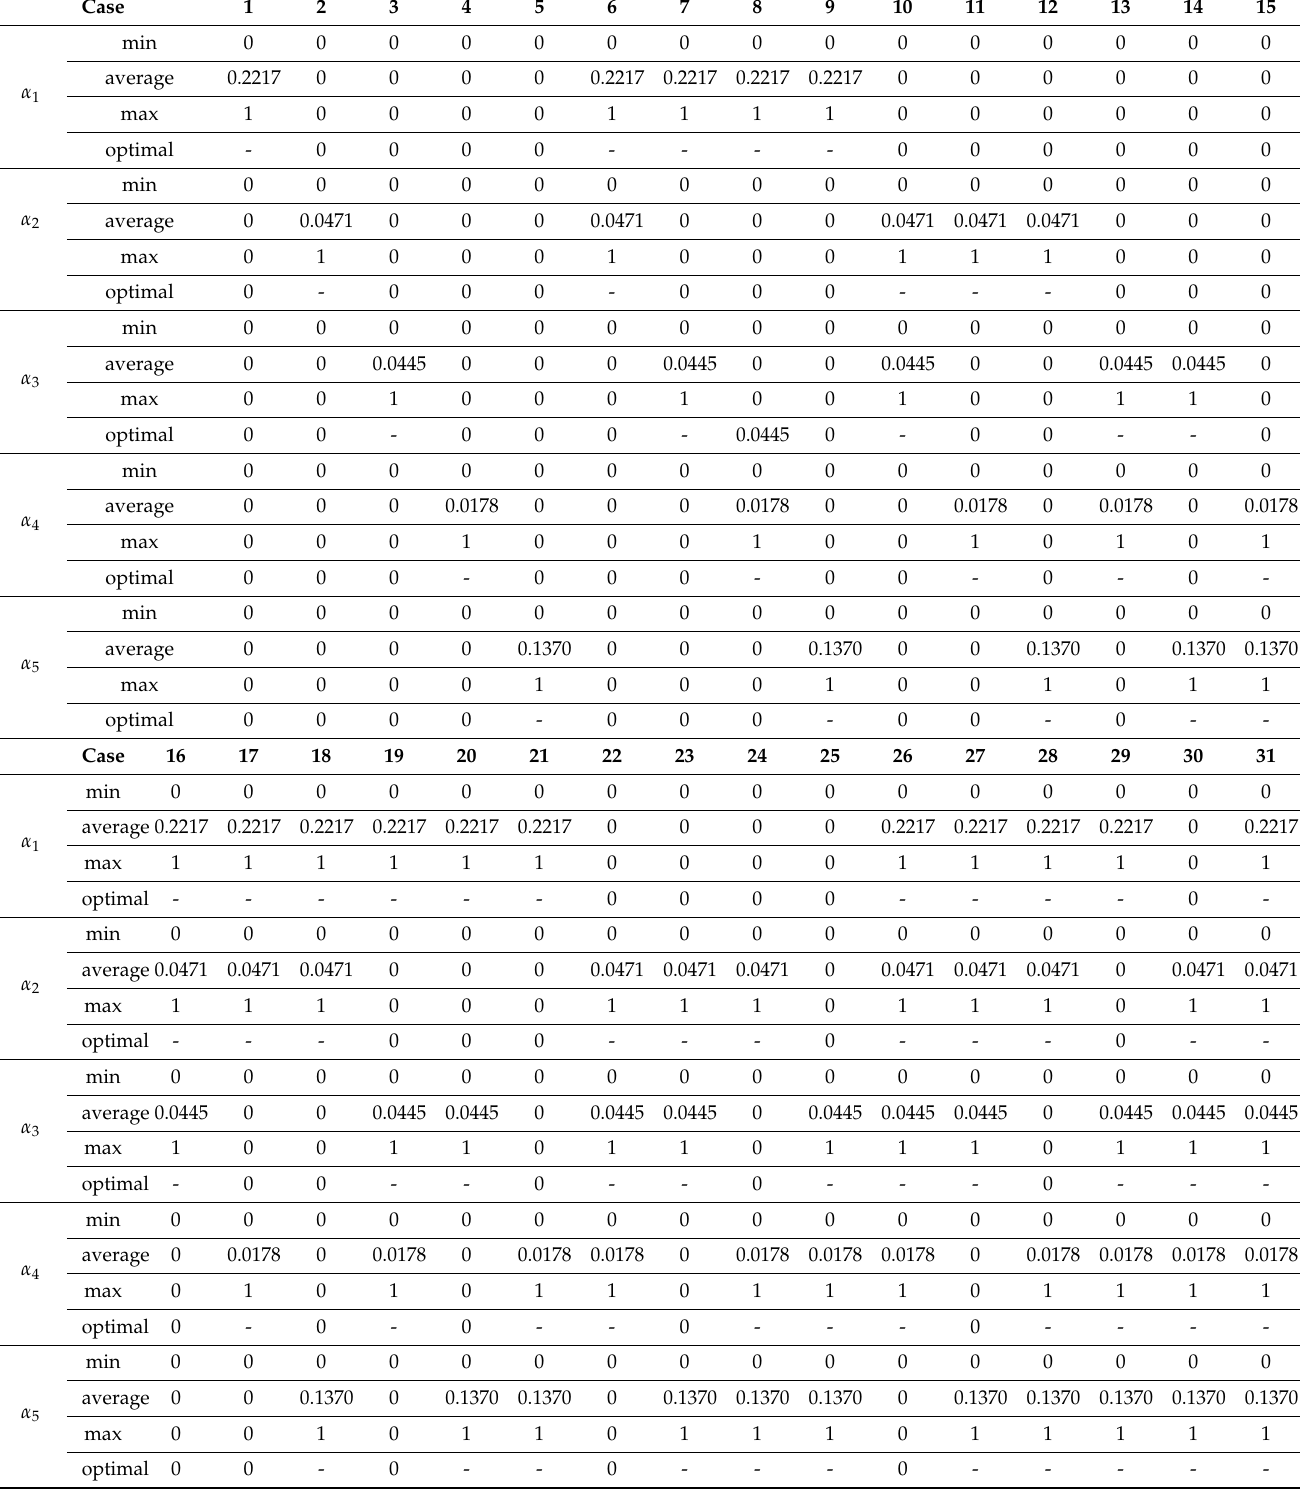
Table 7. Parameters of Figures